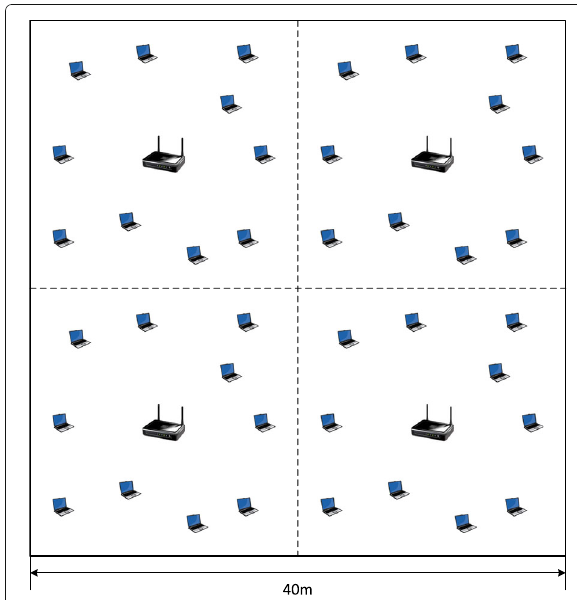
Fig. 9 The multi-WLAN simulation environment. Four APs are placed in a grid-style locations, and mobile stations are randomly deployed in a 40 m × 40 m area. Transmission range is approximately 30 m for packets using MCS index